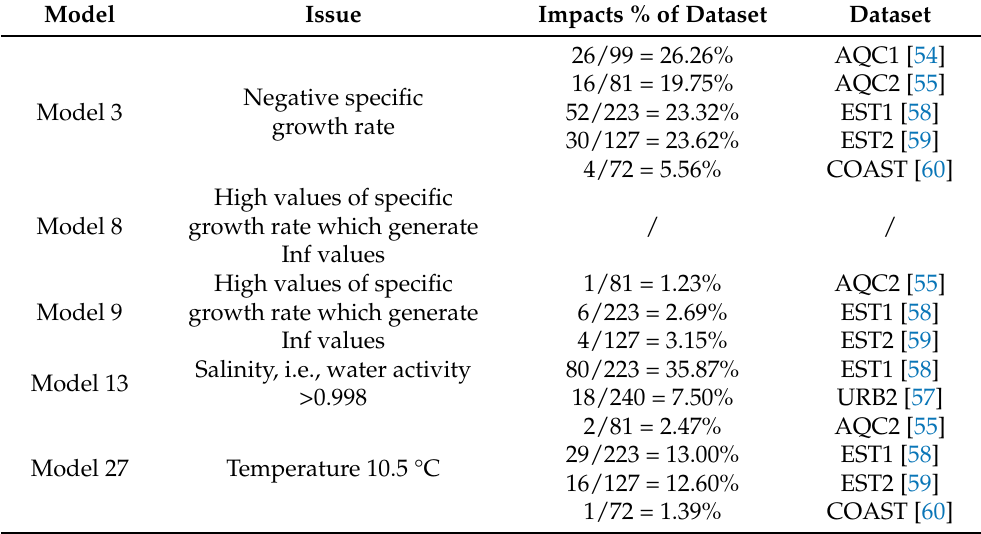
Table A4. Models and their